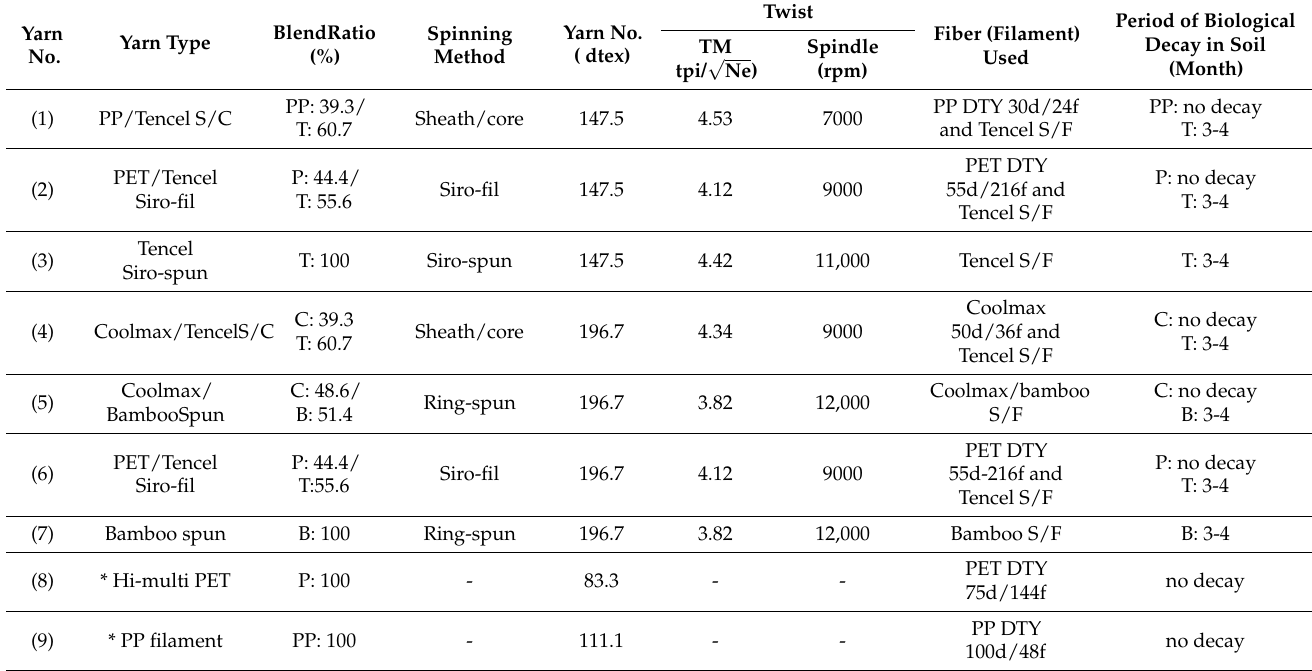
Table 1. Details of the yarn specimens used in this study.